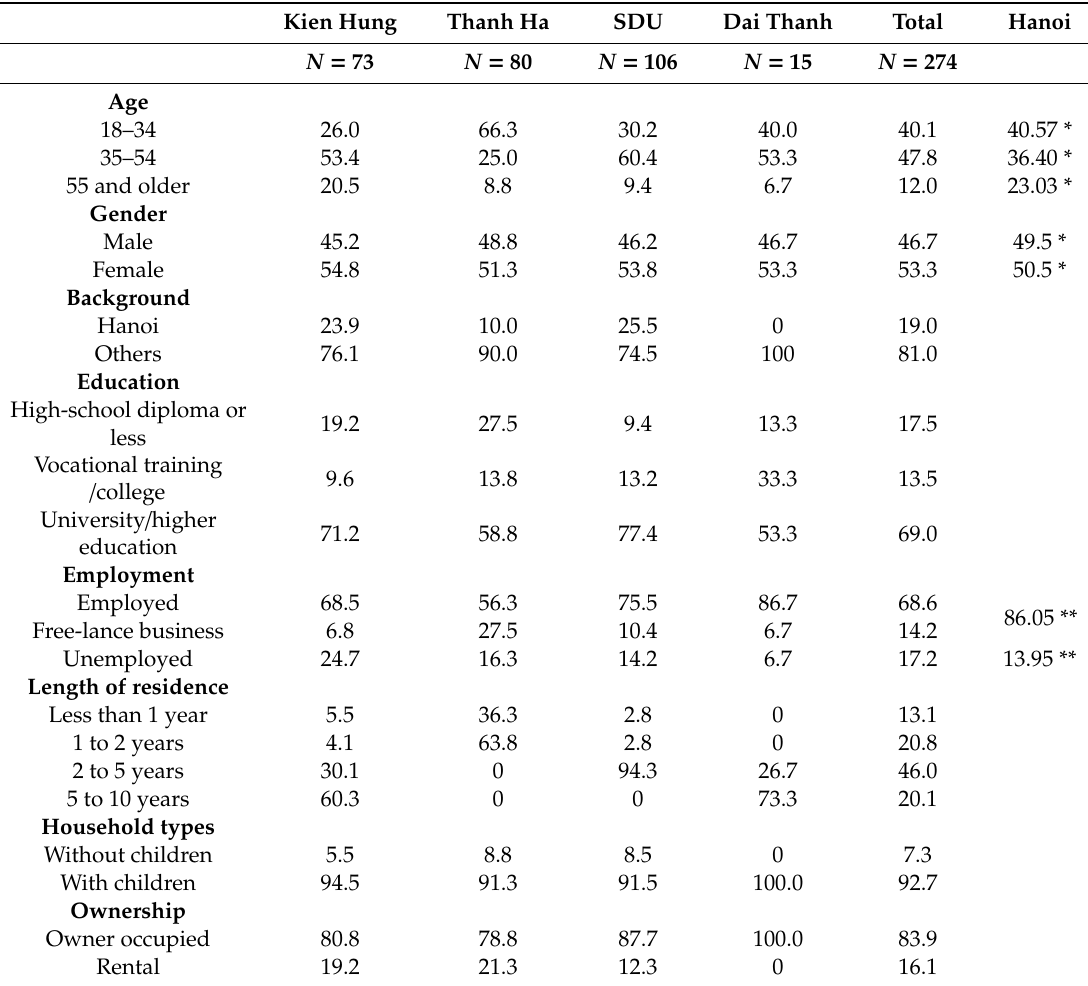
Table 1. Personal characteristics of respondents in four